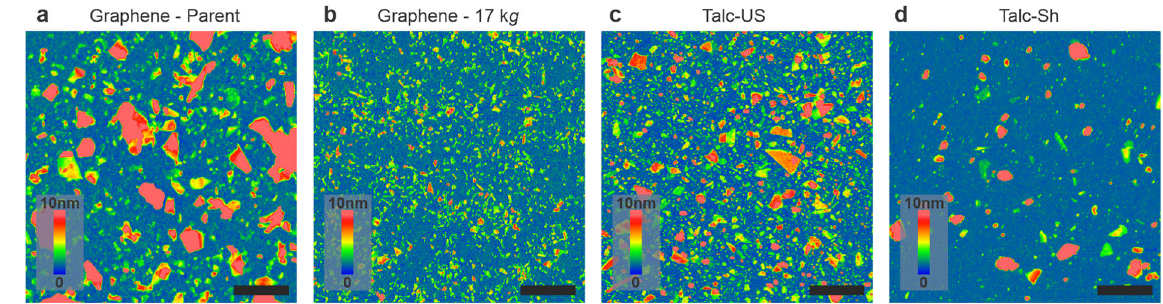
Fig. 1 Atomic force microscopy images of all four investigated systems. Panels a , b show a representative AFM image of the graphene Parent ( 17 k g ) sample, while panels c, d show a typical AFM image of the ultrasound- (shear-) produced talc sample Talc-US ( Talc-Sh ). The 1- µm-long black scale bars in all images indicate their lateral dimensions, while the colored vertical bars indicate sample height (from 0 to 10